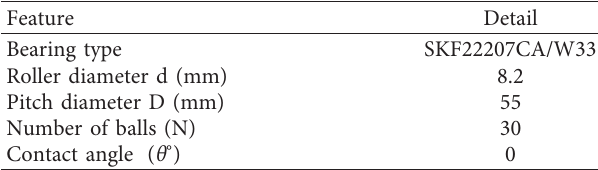
Table 6: The specifications of the test